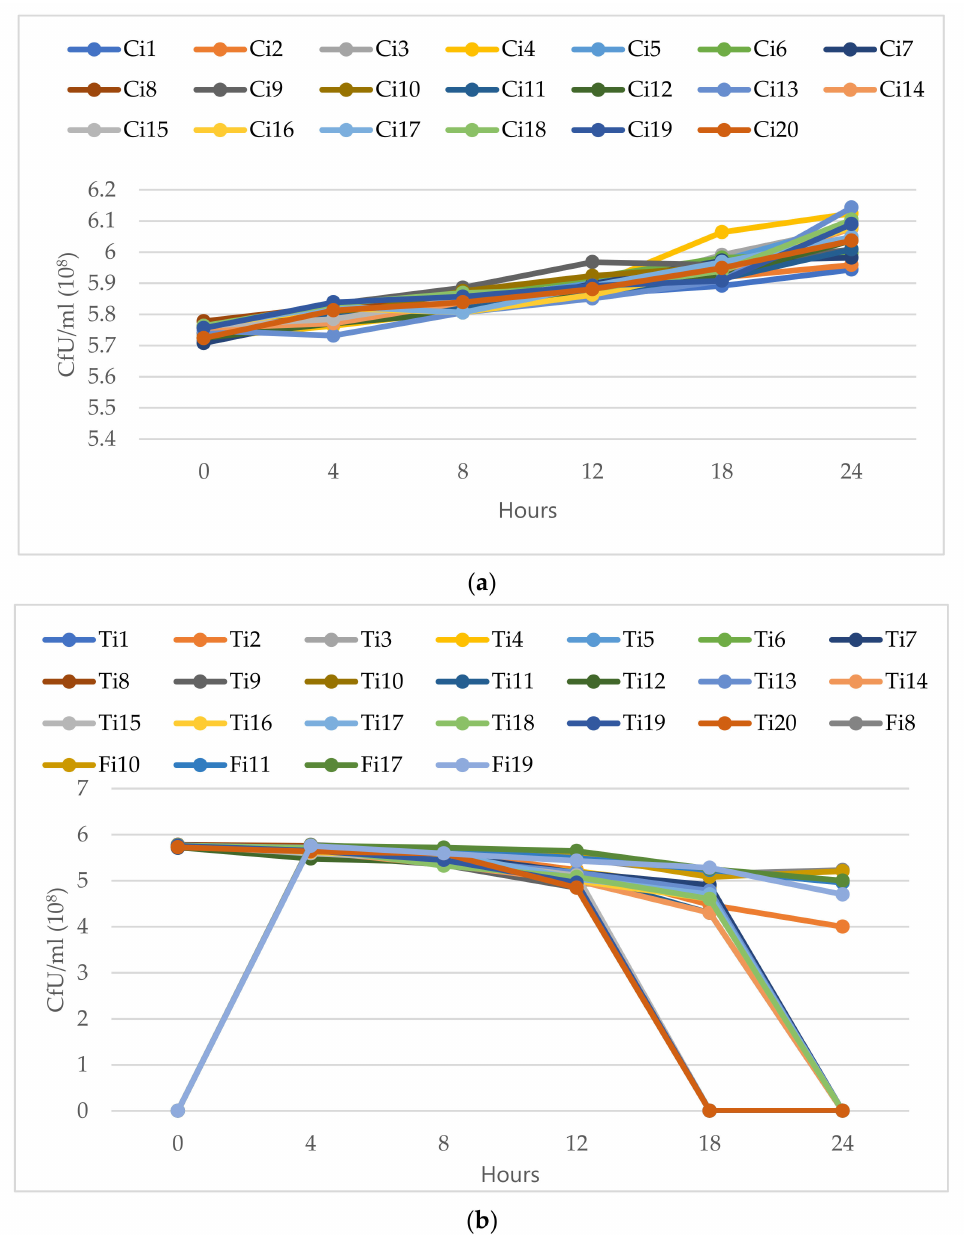
Figure 7. Time-kill of C. albicans on different times (0–24 h): ( a ) untreated (Control) isolates of C. albicans (Ci1–Ci20); ( b ) C. albicans isolates (Ti1–Ti20) treated with Minimum fungicidal concentra- tion (MFC) dose of thyme essential oil (TEO) and C. albicans susceptible isolates (Fi8, Fi10, 1Fi1, Fi17, Fi19) treated with